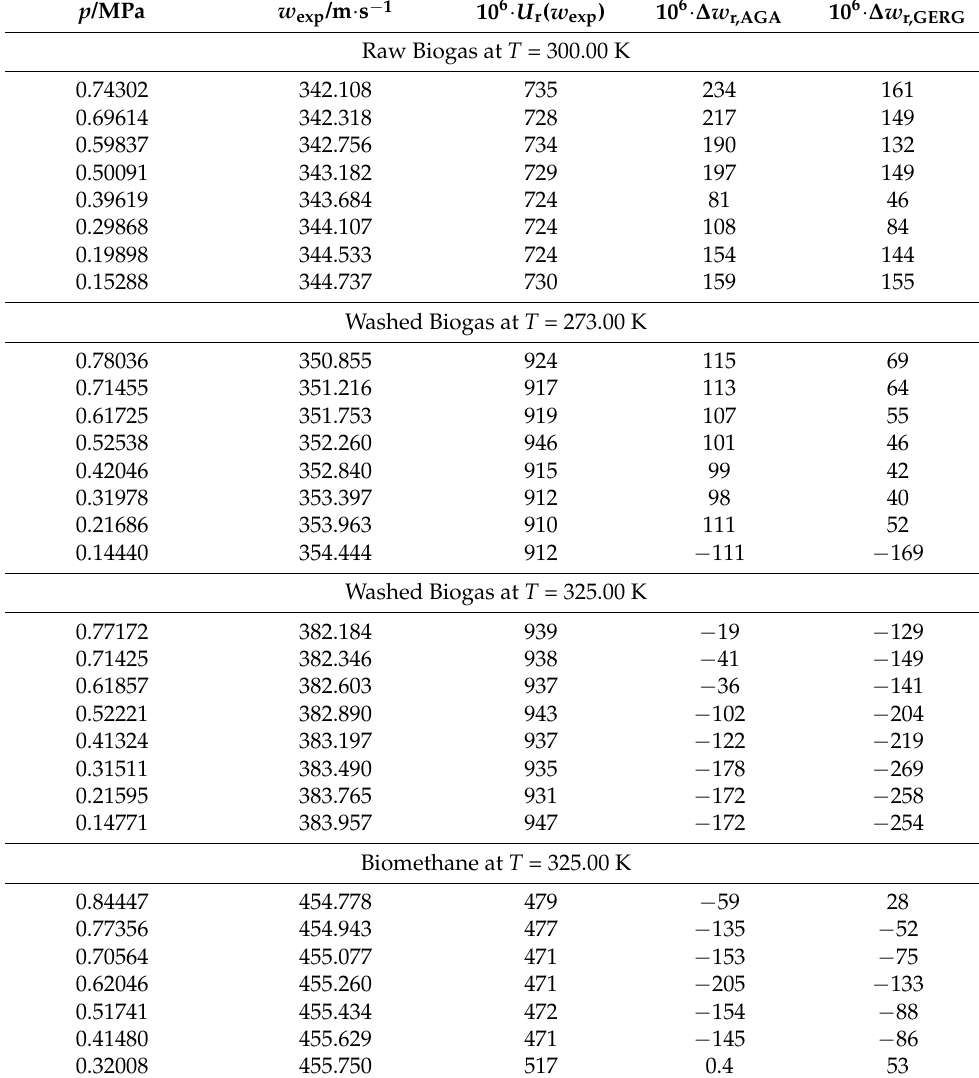
Table 2. Experimental speeds of sound ( w exp ) of the three studied biogas mixtures, relative expanded ( k = 2) uncertainty ( U r ( w exp )), and relative differences ( ∆ w r,EoS = ( w exp − w EoS )/ w EoS ) from the speeds of sound predicted by the AGA8-DC92 and GERG-2008 Equations of